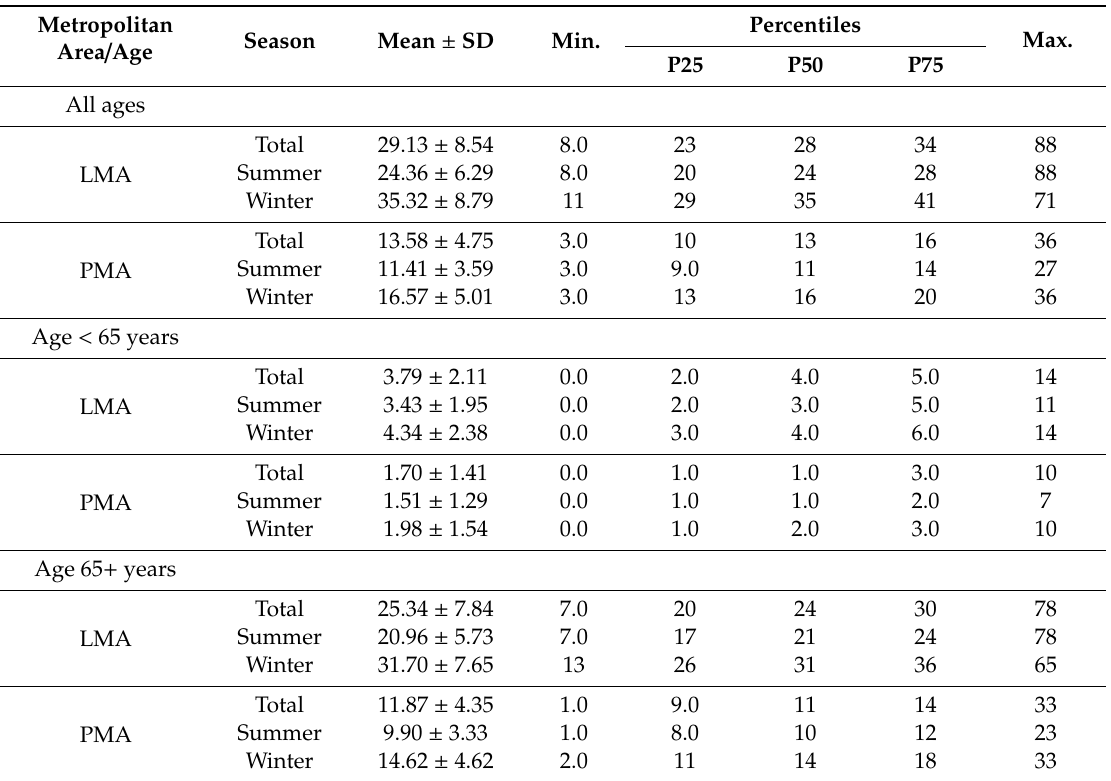
Table 1. Descriptive statistics of daily mortality in Lisbon metropolitan area (LMA) and Porto metropolitan area (PMA), 1991–2005.